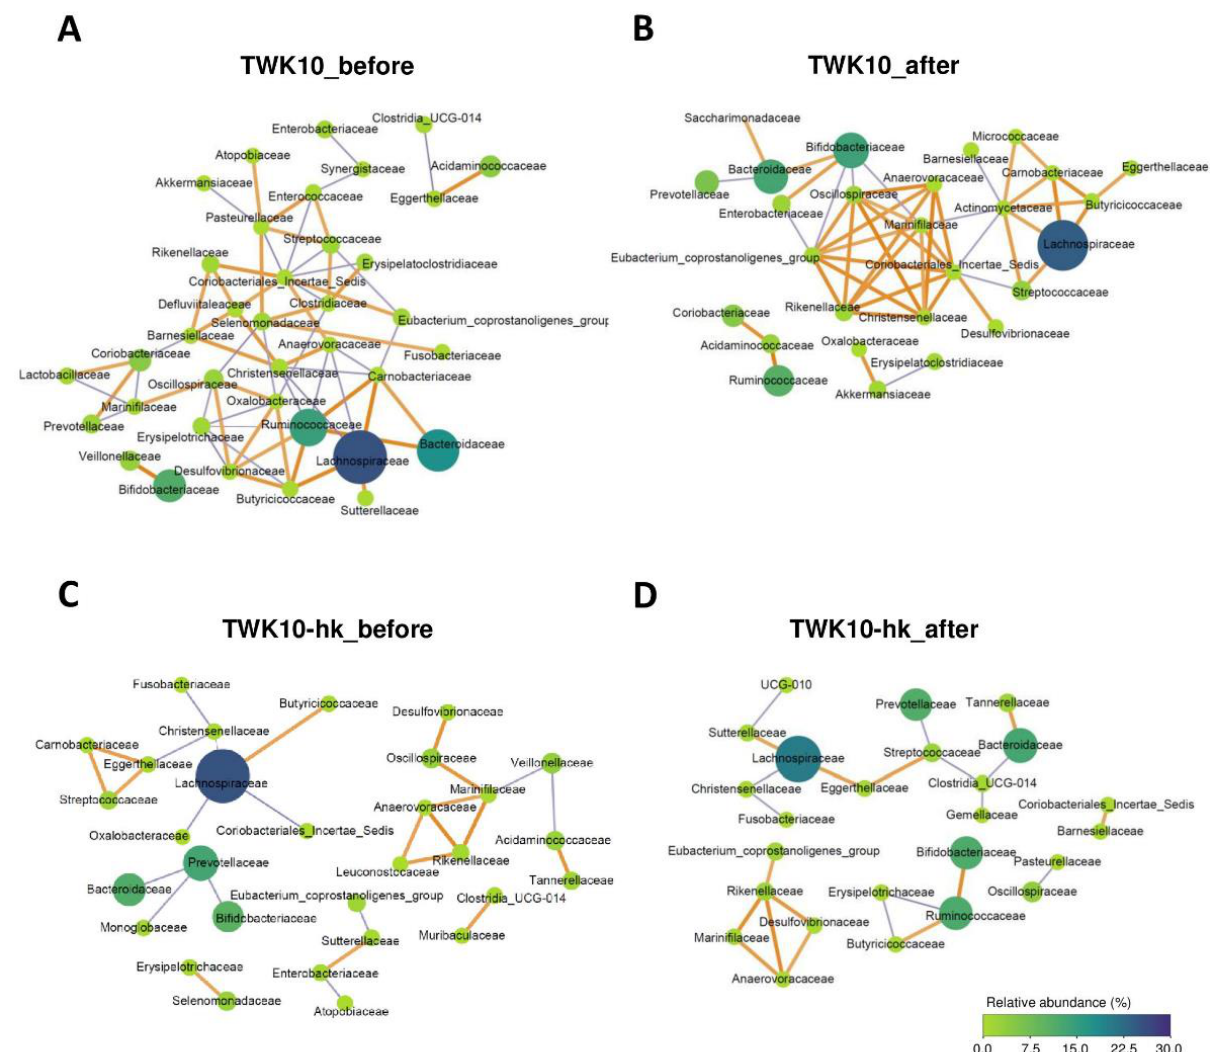
Figure 4. Co-occurrence network analysis of the gut microbiota. Bacterial networks were generated using SparCC correlation coefficients, based on relative abundances at the family level: ( A ) In the TWK10 group before administration (TWK10_before), there were 37 nodes, and correlation coefficients ranged from |0.60| to |0.92|; ( B ) In the TWK10 group after administration (TWK10_after), there were 28 nodes, and correlation coefficients ranged from |0.60| to |0.74|; ( C ) In the TWK10-hk group before administration (TWK10-hk_before), there were 30 nodes, and the correlation coefficients ranged from |0.61| to |1.00|; ( D ) In the TWK10-hk group after administration (TWK10-hk_after), there were 25 nodes, and correlation coefficients range from |0.60| to |0.85|. Nodes represent bacteria families; grey and orange color edges represent negative and positive correlation coefficients, respectively. The size and the degree of the green color of nodes in the network represent the relative abundance of each taxon in each